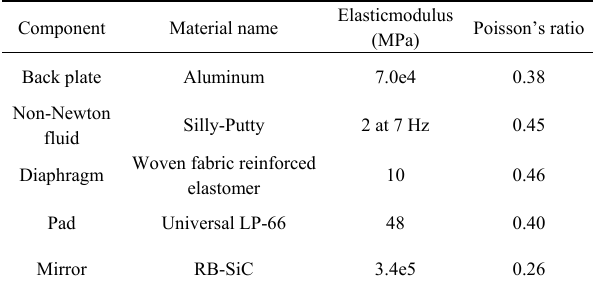
Fig. 5 Symmetrical FEA models for: (a) old and (b) new RC laps. Table 1 Assembly-component material